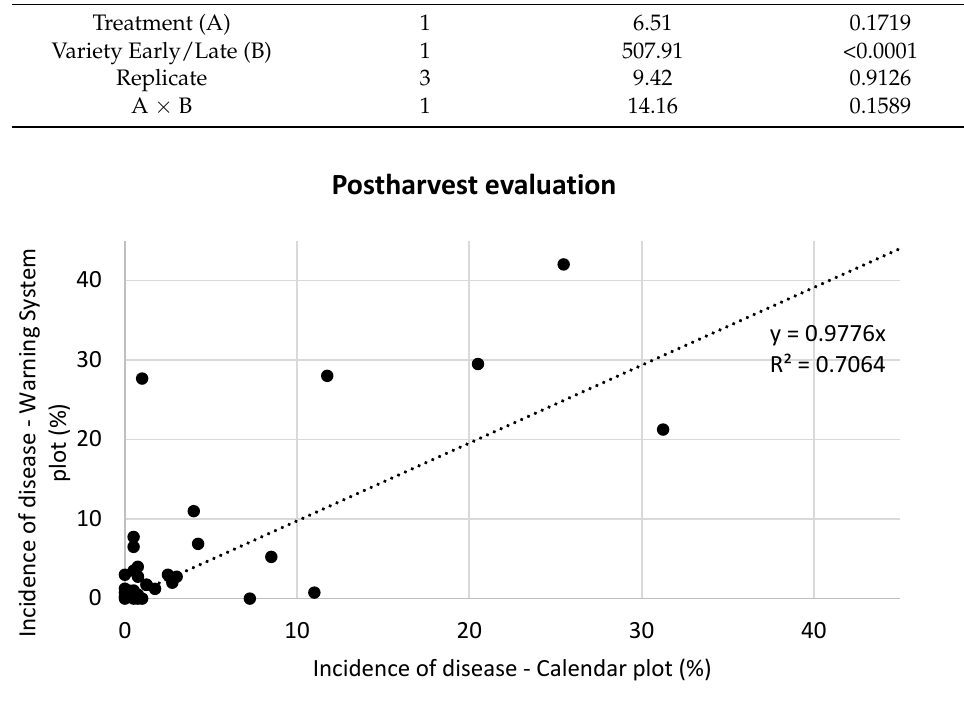
Table 3. Summary of analysis of variance of brown rot incidence recorded in postharvest at harvest time among 38 trials conducted during 6 seasons (2012–2017).